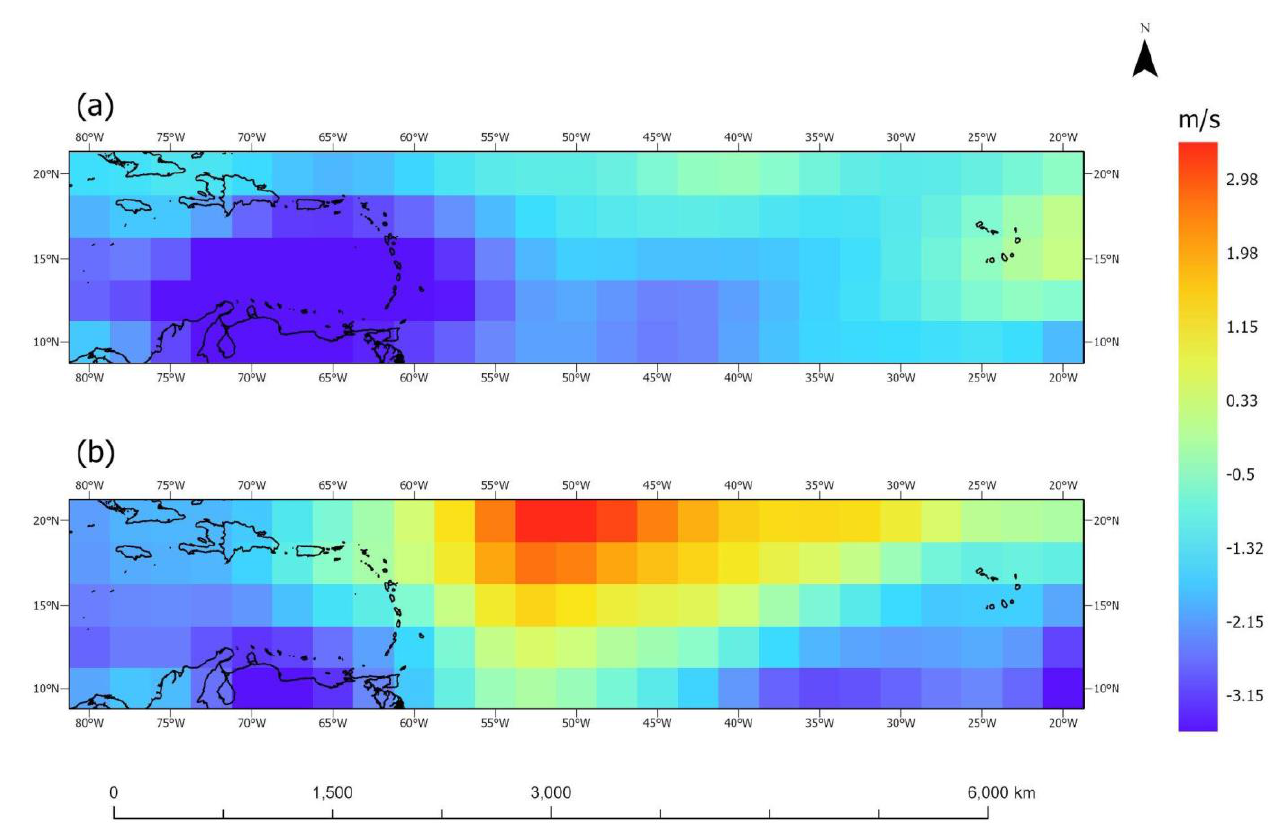
Figure 7. VWS composite anomalies in the NA basin for the 2005 ( a ) and 2020 ( b ) hurricane seasons (June – November).